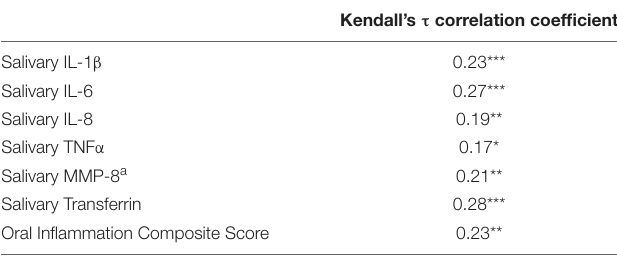
TABLE 3 | Salivary human cytomegalovirus IgG levels were positively correlated with all markers related to oral inflammation and tissue integrity ( N = 98).